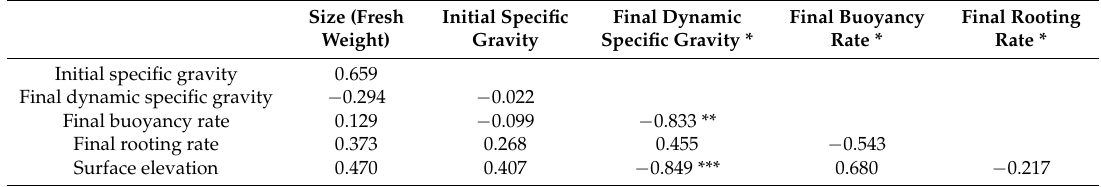
Table 4. Correlations between propagule dispersal attributes and tidal distribution patterns of eight mangrove species along the Wenchang